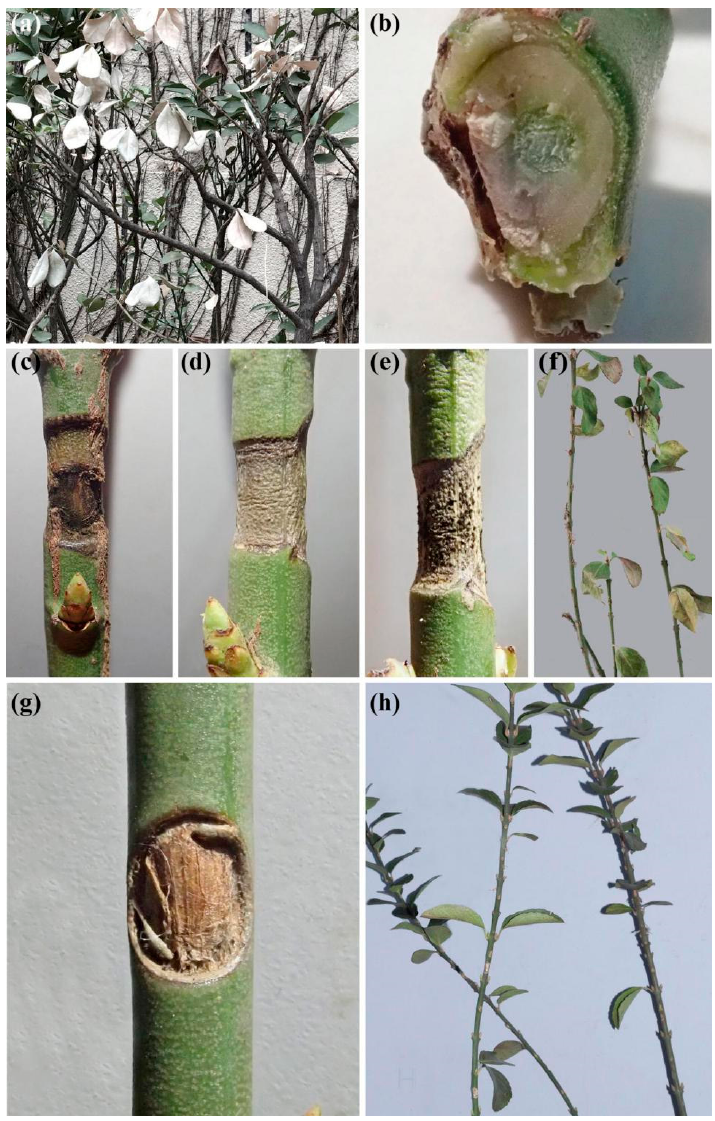
Figure 4. Stem blight symptoms on Euonymus alatus caused by Cytospora haidianensis. ( a ) Death of the whole plant caused by C. haidianensis on University Road, Beijing, China. ( b ) Stem blight caused by C. haidianensis in the greenhouse. Symptoms after ( c ) one week, ( d ) two weeks and ( e ) three weeks after inoculation of C. haidianensis . ( f ) Symptoms on Euonymus alatus twigs three weeks after inoculation of Cytospora haidianensis. ( g,h ) No symptoms on Euonymus alatus twigs after three weeks of inoculation with agar block (control) .